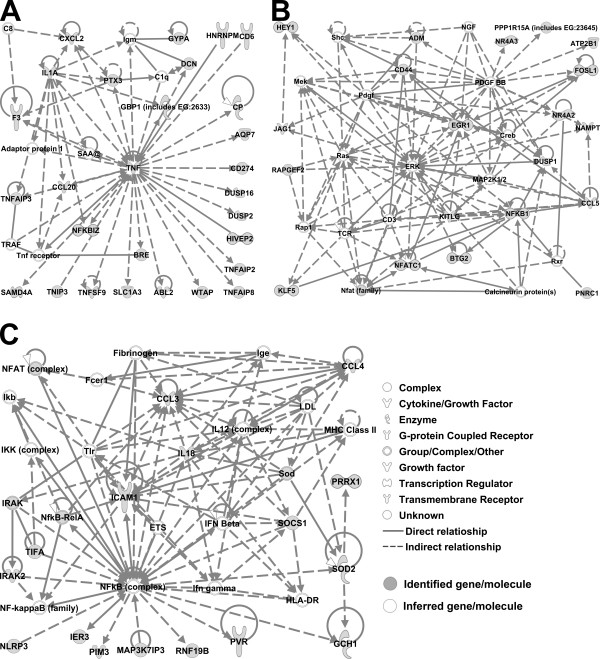
Networks of genes upregulated on spore-infected cells as determined by Ingenuity analysis. Genes depicted in gray were identified by the microarray results as differentially expressed. Genes depicted in white are inferred genes. These are genes that should be differentially expressed on the basis of Ingenuity analysis, and although they were expressed, differential expression was not identified by statistical analysis of the microarray results. A) First network, B) Second network, C) Third network. Genes that are not expressed under any conditions were removed from the networks.